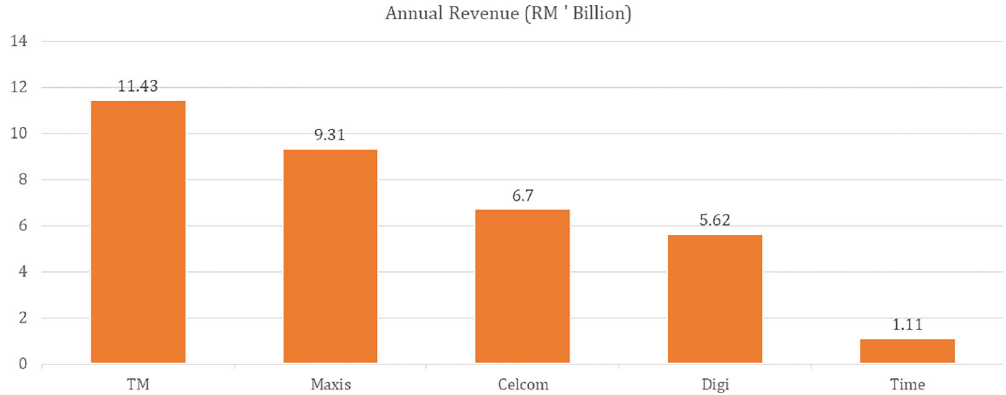
Figure 1. Telecommunications and Internet industry: Participants Annual Revenue as of 31 st December